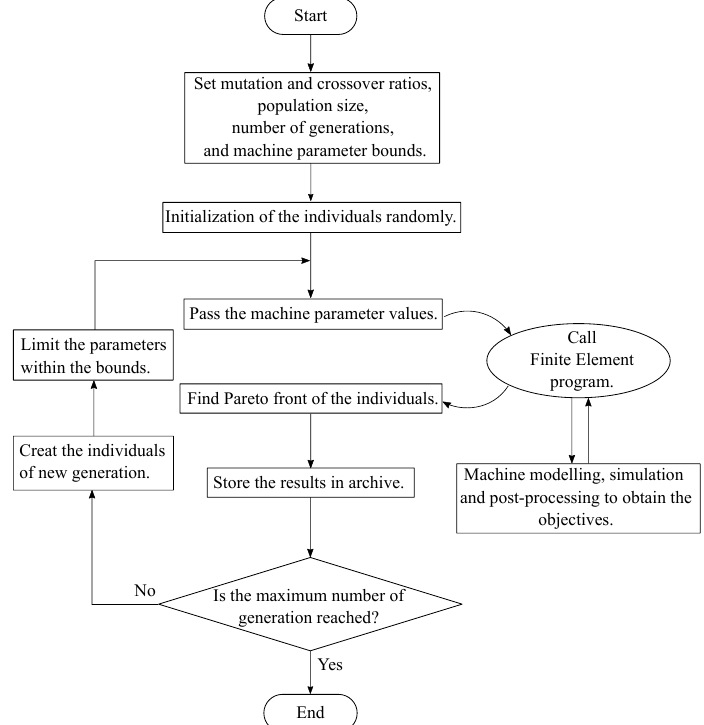
Figure 2. Optimization procedure using FEA and DE